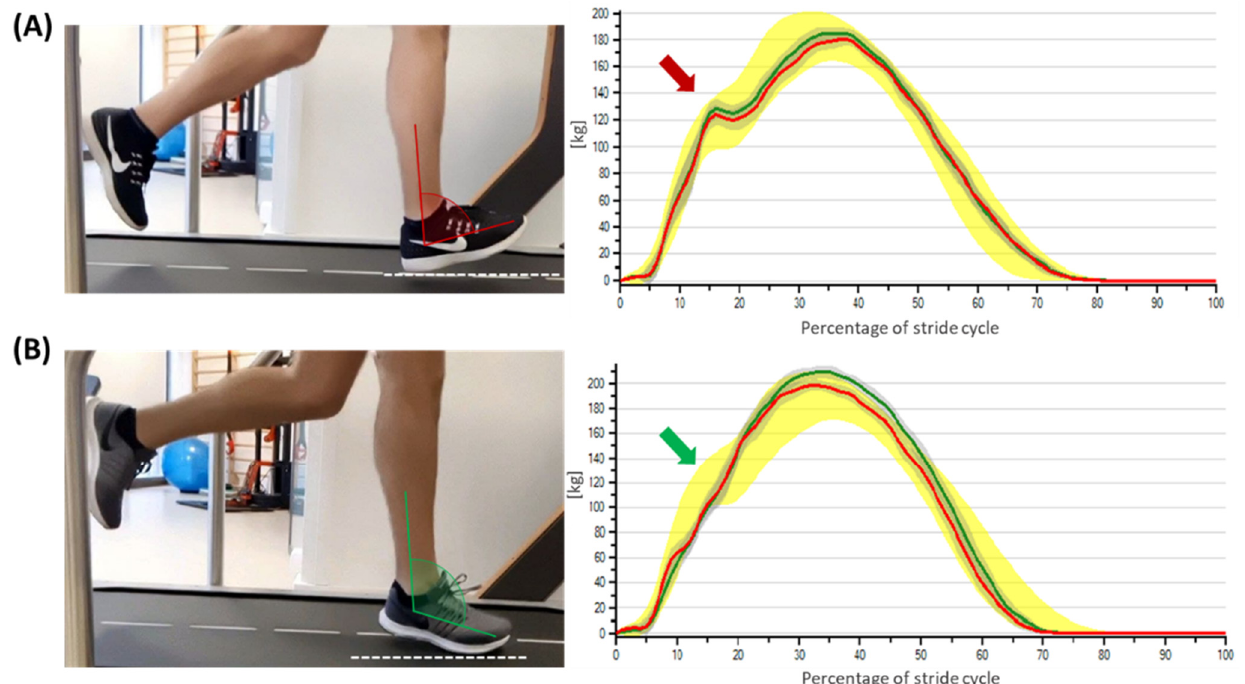
Figure 2. The impact peak force graphs showing impact peak presence ( A ), the red arrow specifies the impact peak occurrence; and impact peak absence ( B ), the green arrow specifies the impact peak absence. The red line represents the left side of the body, the green line represents the right side, the yellow band represents normal values.